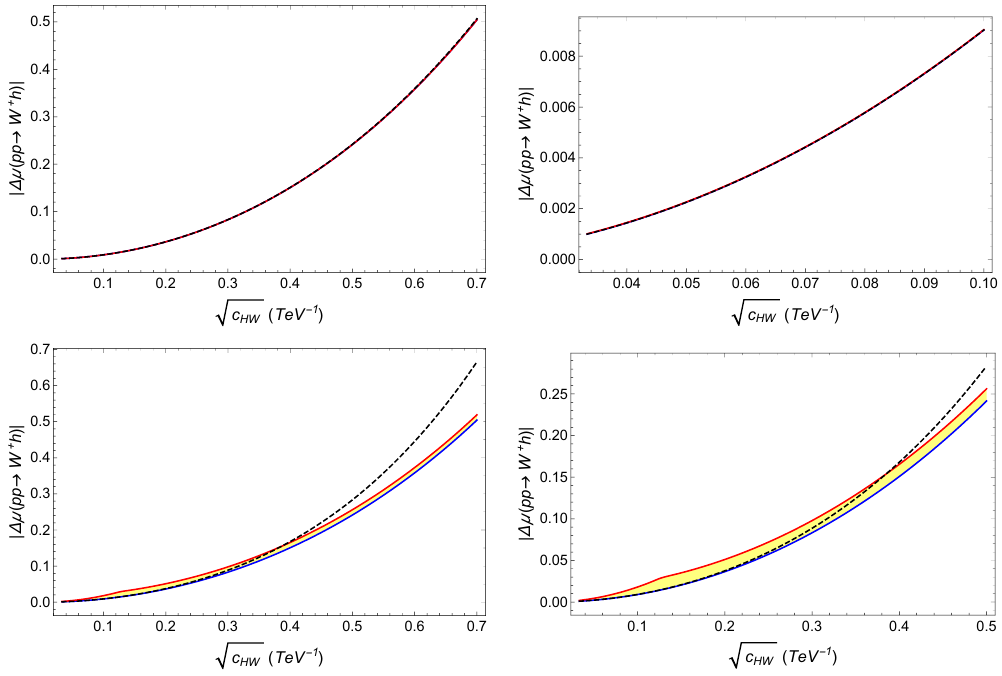
p Figure 2 . Relative deviation in the inclusive cross section (cid:27) ( pp ! h W + ) at the LHC ( s = 13 TeV) from its SM value including dimension-6 and dimension-8 e(cid:11)ects. The blue line shows the result of including O HW as the only dimension-6 operator and without considering dimension- 8 operators. The red line indicates the deviation as a function of c HW including the maximum possible dimension-8 e(cid:11)ect consistent with the EFT expansion. The black dashed line shows the result if dimension-6 and dimension-8 operator coe(cid:14)cients are equal, c HW = c 8 ;i (i.e. (cid:3) 8 = (cid:3) 6 ). In the top two panels the dimension-8 coe(cid:14)cients are all equal, while in the bottom two panels p we take their magnitudes to be equal but assign their signs to maximize their e(cid:11)ects at high s . p The left panels shows values of c HW out to the current 95% CL limit, which following the global analysis in ref. [90] is 0 : 631 TeV (cid:0) 1 . In the right panels we have zoomed in to smaller values of c HW to make the dimension-8 e(cid:11)ects more